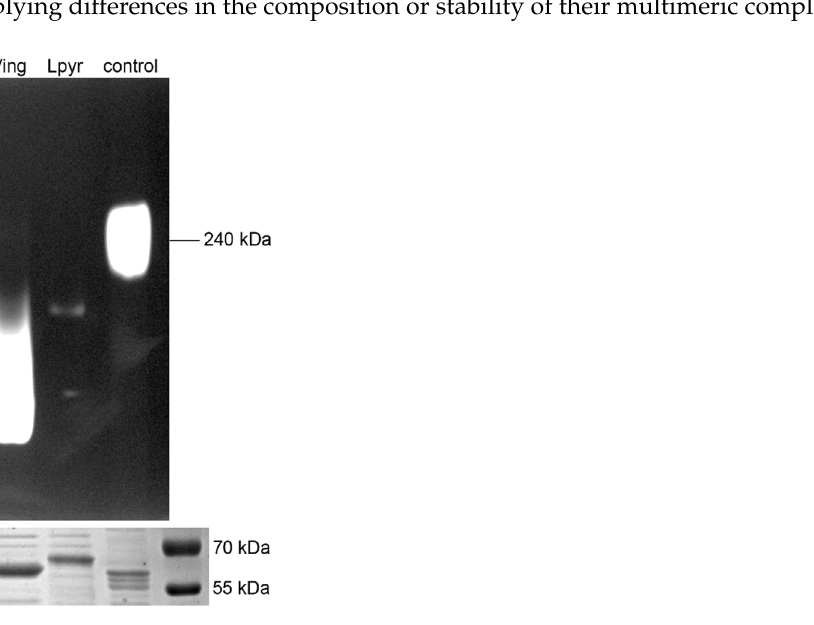
Figure 4. In-gel activity of the purified catalases of Blastocrithidia sp. P57 (Bsp), Vickermania ingeno- plastis CP21 (Ving), and Leptomonas pyrrhocoris H10 (Lpyr). The bovine liver catalase (homo-tetramer of approximately 240 kDa, lane 4) served as a control. Ten and five micrograms were assayed for trypanosomatids’ and bovine enzymes, respectively. The loading control (SDS-PAGE) is shown below. Next, we investigated the kinetic properties of the three trypanosomatid enzymes. Table 1. Observed and calculated by non-linear regression analysis V MAX and K M values of trypano- somatid catalases expressed (in μ M/min and mM, respectively).